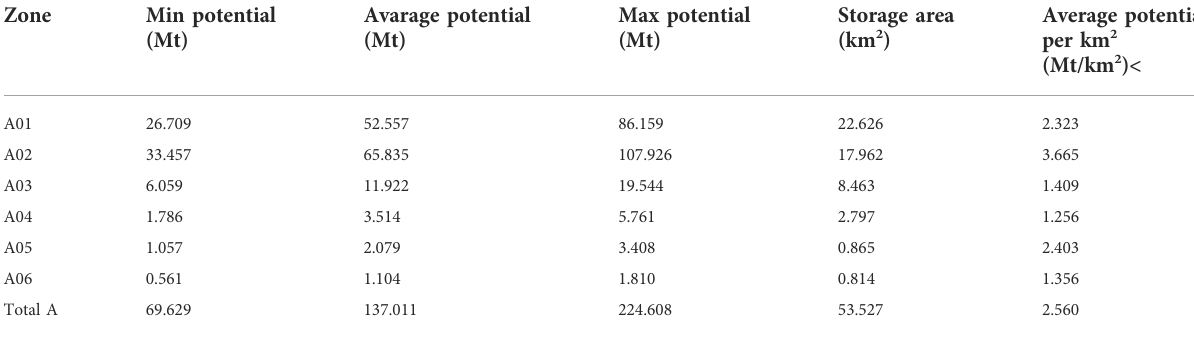
TABLE 4 CO 2 geological storage potential of reservoir A